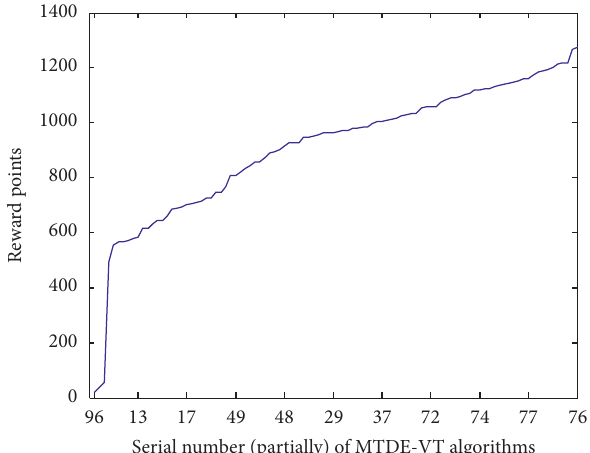
Figure 2: Total score of MTDE-VT algorithms with different parameter settings. Table 5: Best fitness obtained by all MTDE-VT algorithms and the corresponding parameter setting.